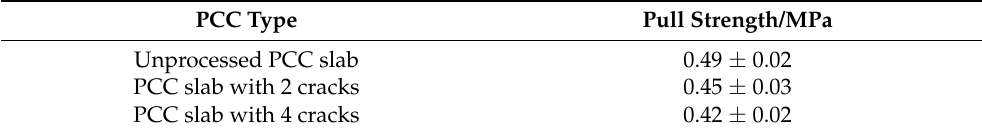
Table 6. Pull strength test